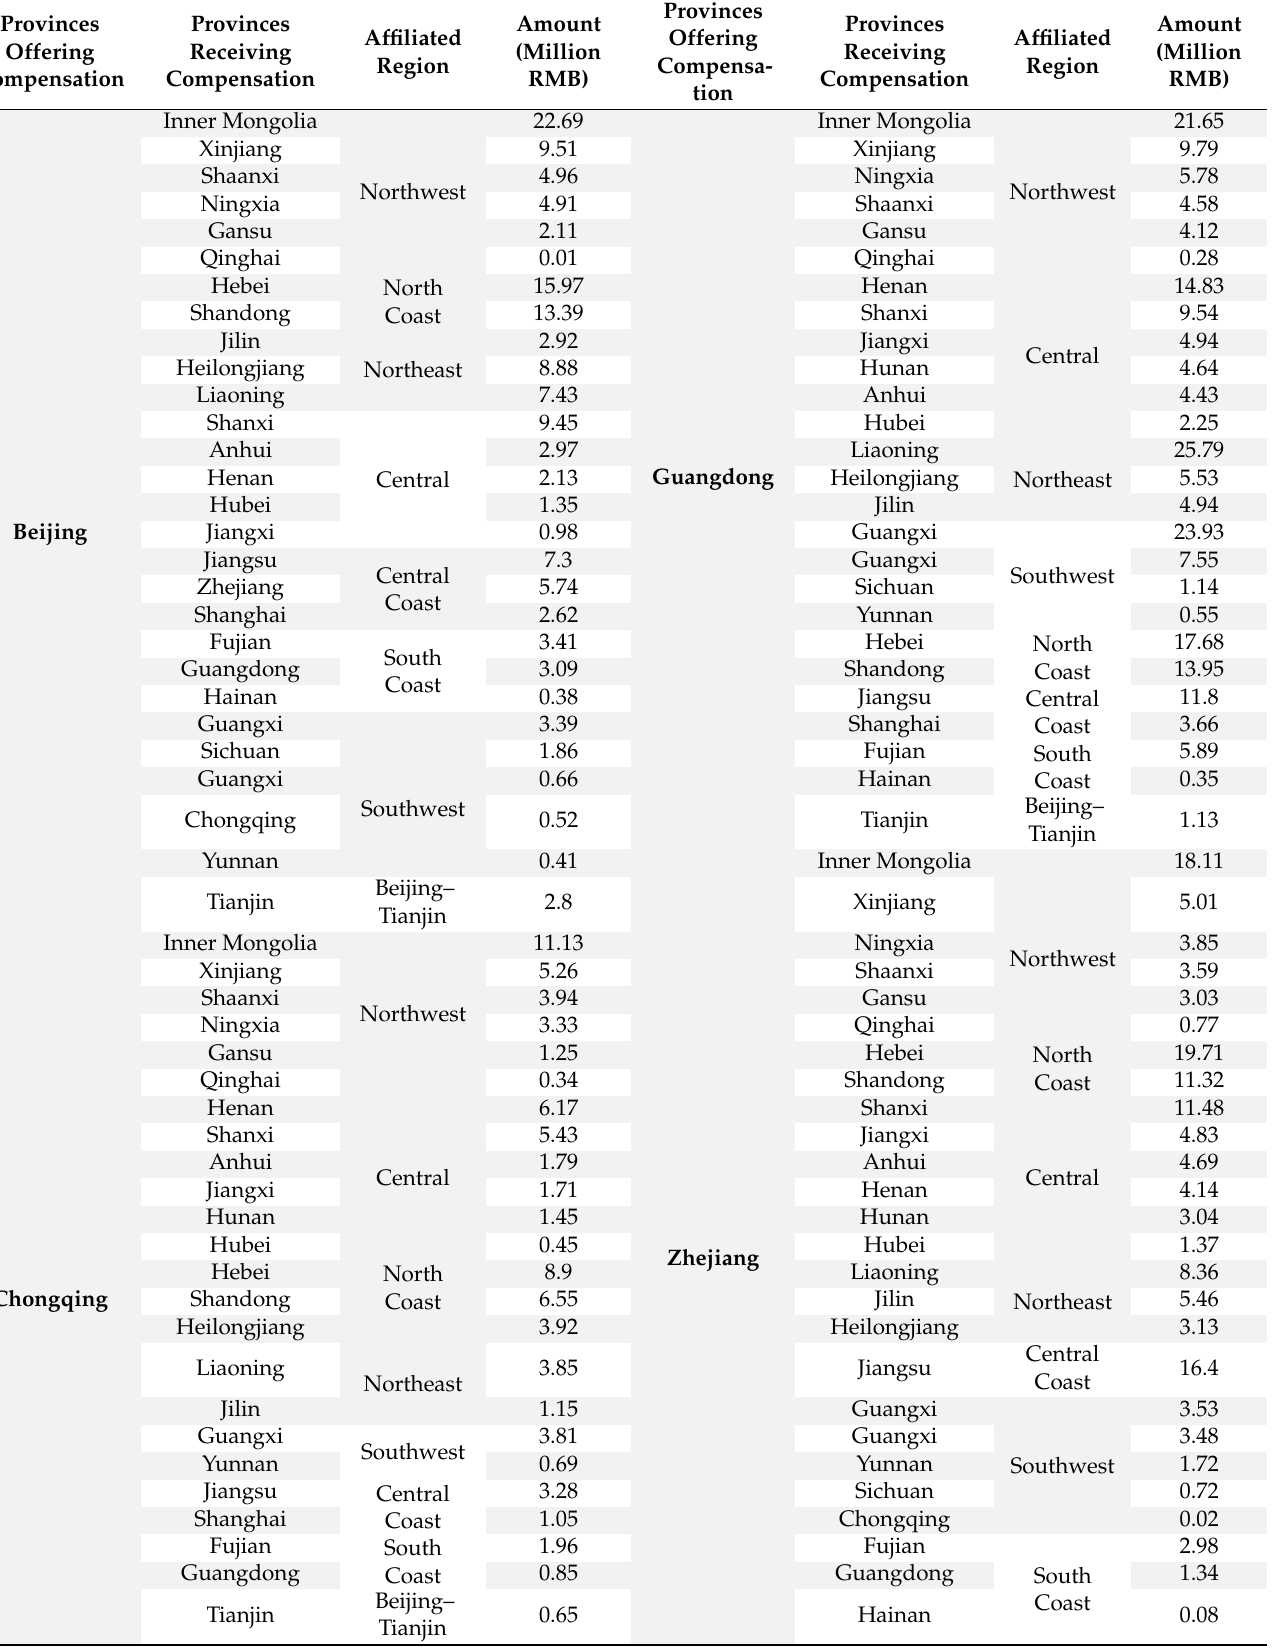
Table 3. Top eight provinces in terms of the carbon compensation